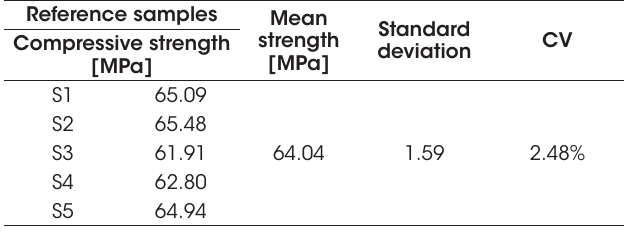
The rupture configurations of samples cast in horizontal position